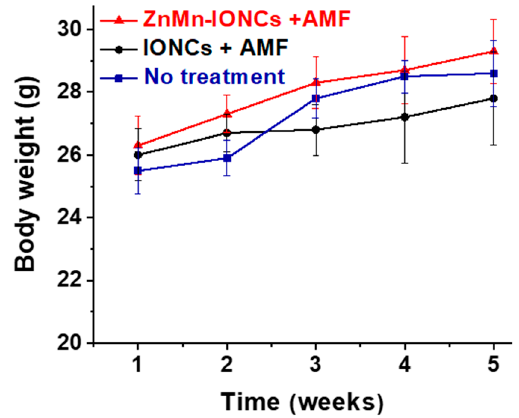
Figure 9. Changes in body weights of non-treated mice and animals exposed to 4 cycles of ZnMn-IONC- and IONC-mediated hyperthermia.